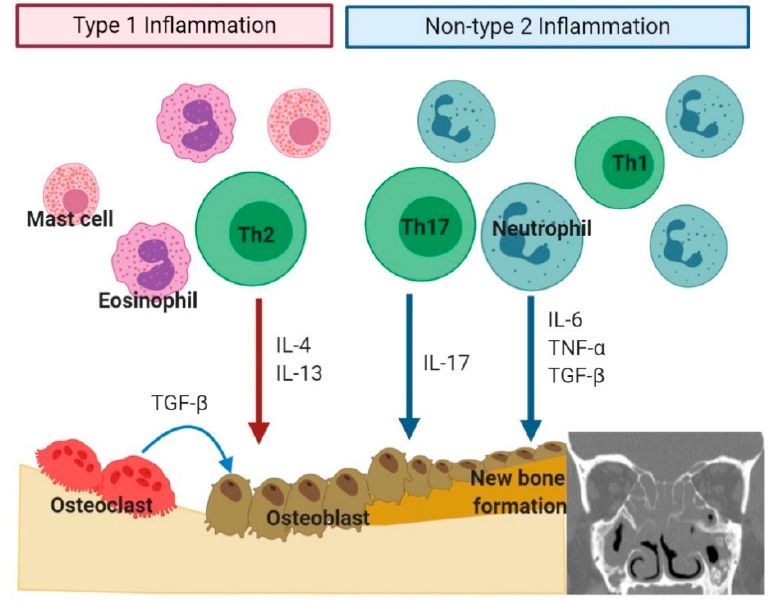
Figure 3. Bone remodeling based on the type of inflammation (type 2 inflammation versus non-type 2 inflammation) in chronic rhinosinusitis (figure created using Biorender.com).